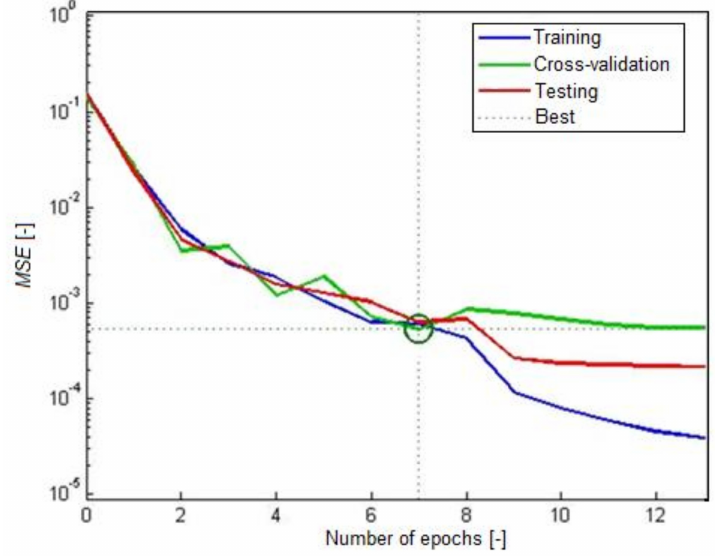
Figure 7. Performance in the FA-ANN with the optimum 8-8-4-1